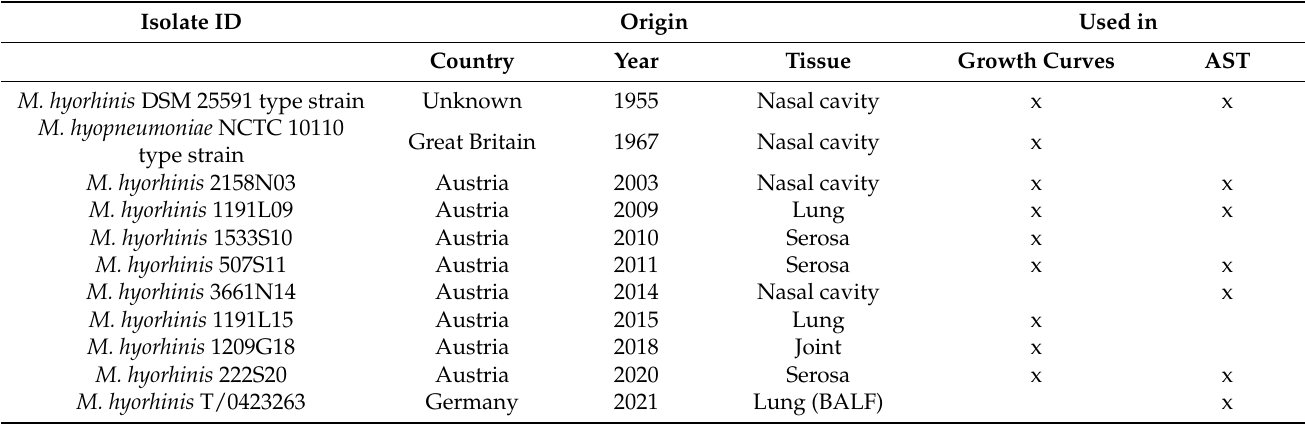
Table 1. Origins of type strains and field isolates used for growth curves and the development of the AST